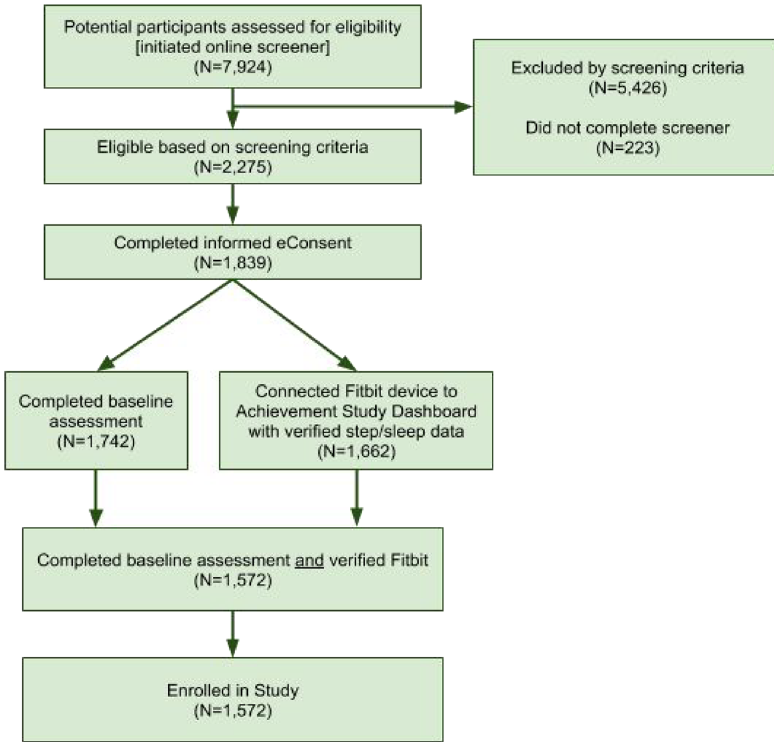
Fig. 1 Flow diagram of participants from recruitment to study enrollment. Flow of participants (starting at top) from initial eligibility screening to informed consent to to enrollment completion is shown. Participants were considered enrolled if they completed the baseline assessment and connected a Fitbit device after consenting to the